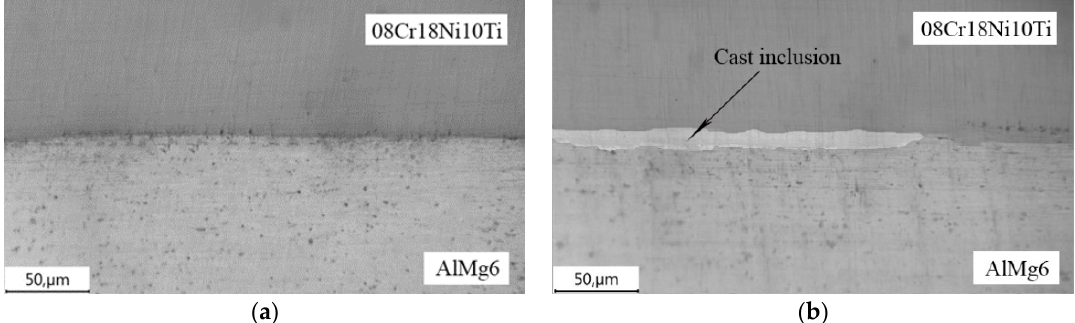
Figure 9. SEM micrographs: ( a ) the weld interface beside the welding point; ( b ) the weld interface the other edge of the bimetal.